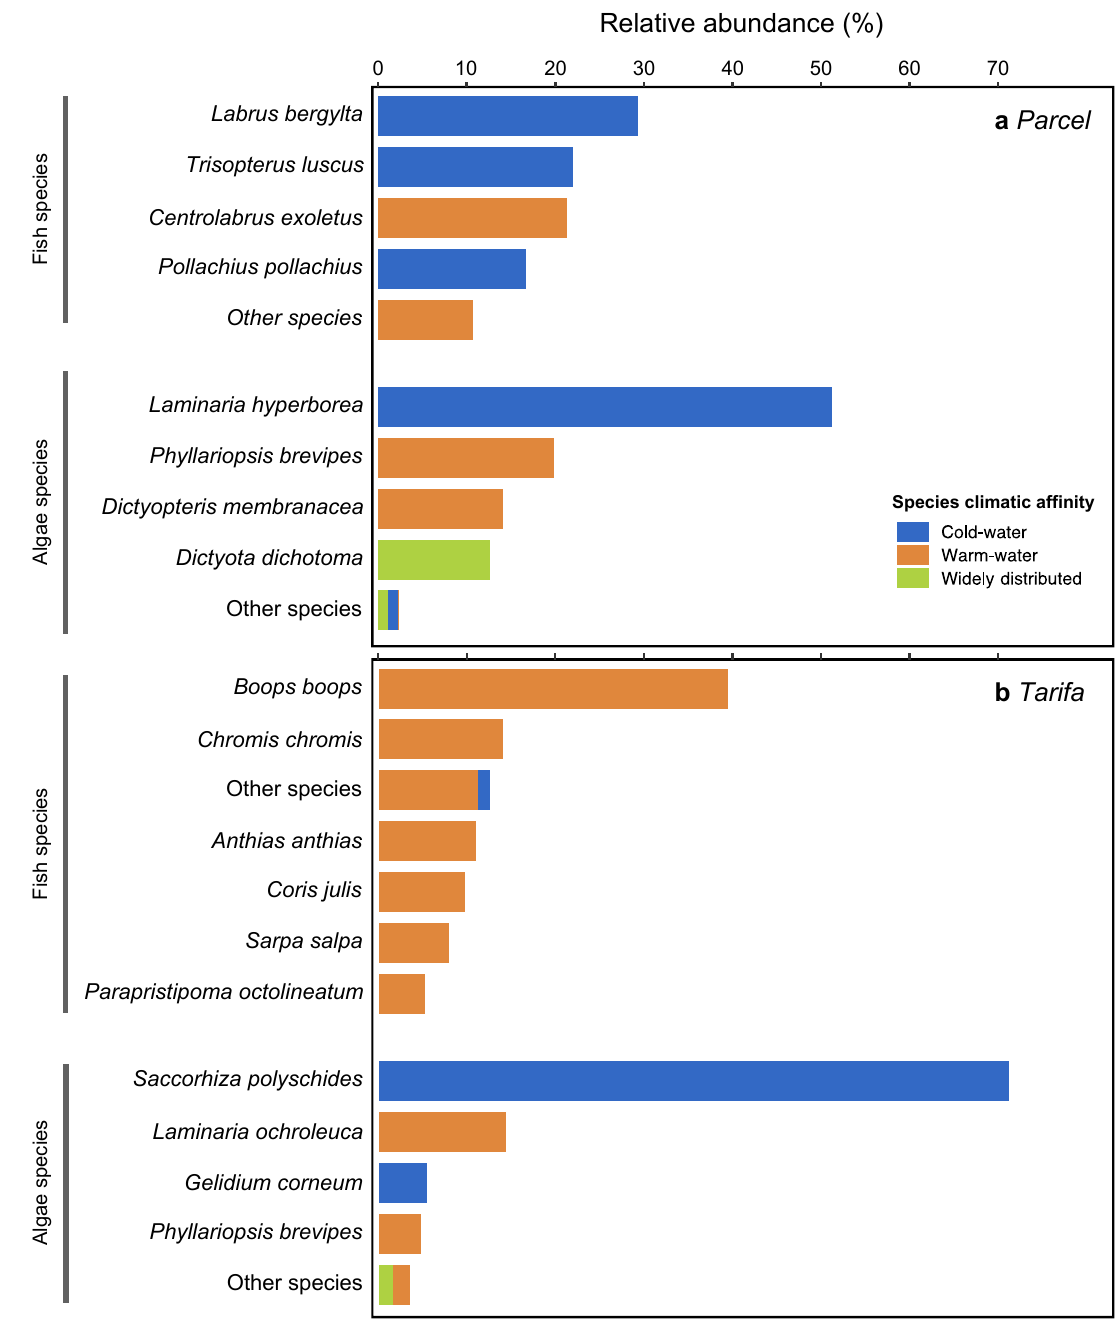
Figure 4. Relative abundance for the main species of fish (based on numbers of individuals) and algae (based on wet biomass) by climatic a ffi nity in Parcel ( a ) and Tarifa ( b